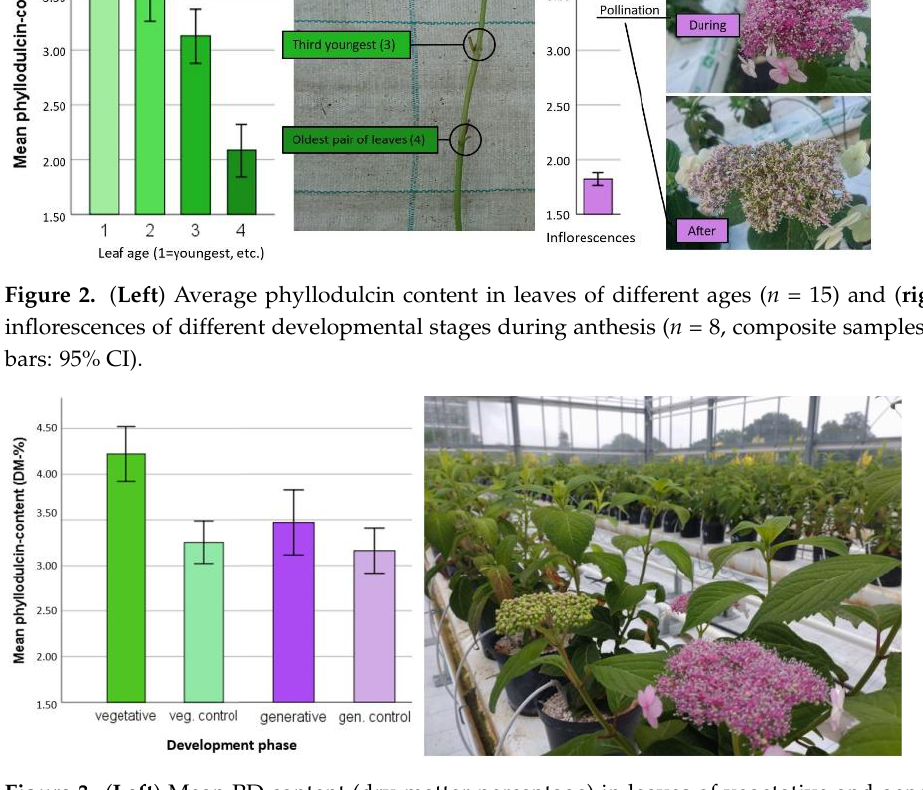
Figure 3 Figure 3. ( Left ) Mean PD content (dry-matter percentage) in leaves of vegetative and generative H. macrophylla ( n = 72) after several MeJA applications (error bars: 95% CI). ( Right ) Plant culture exhibiting vegetative and generative growth in the same